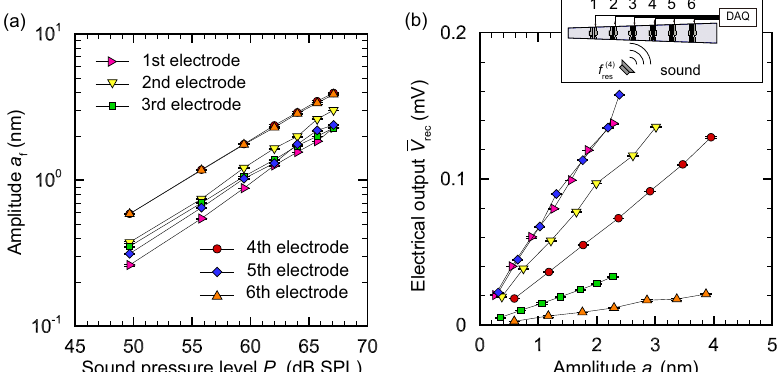
Figure 8. ( a ) Relationship between amplitude a f at x ( i ) ( i = 1, 2, · · · , 6) and sound pressure level P s ( 4 ) = 5.84 kHz. The membrane vibration increased with the sound pressure level applied for f s = f res to the artificial cochlear epithelium. ( b ) Relationship between electrical output ¯ V ( 4 ) = 5.84 kHz. Amplitude a and amplitude a f at x ( i ) for f s = f res the recognition electrodes had a linear relationship.